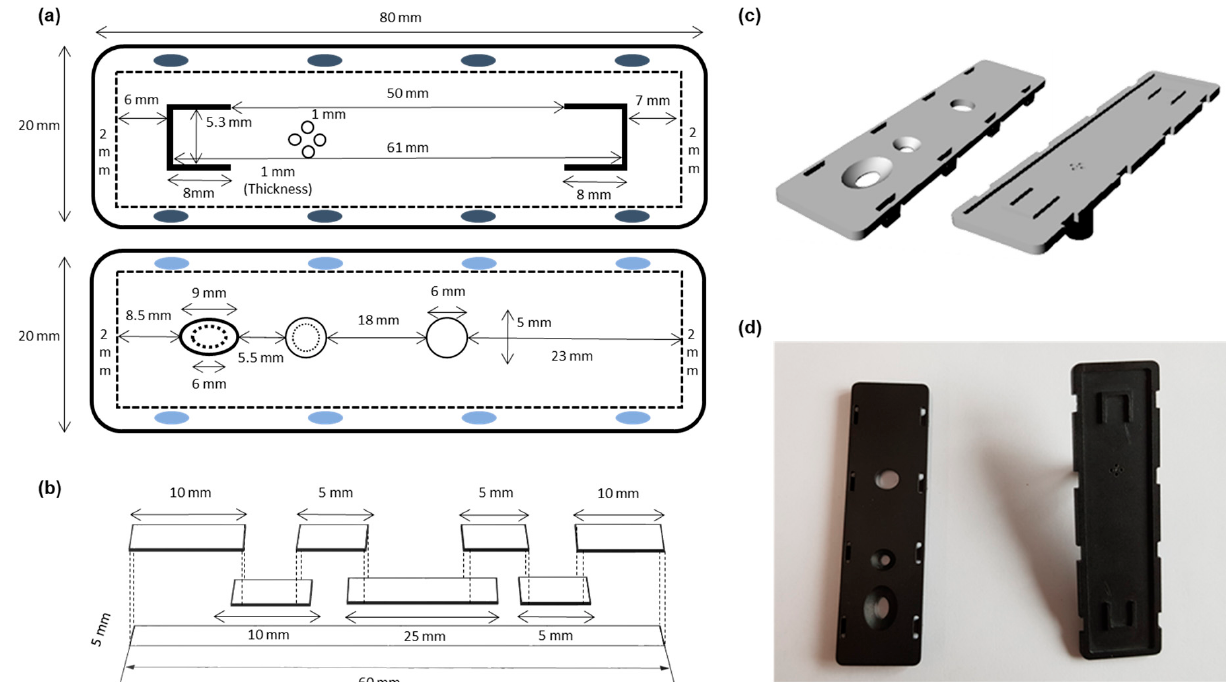
Figure 2. 3D printing of airborne bacteria collection kit. ( a ) Hand drawing of the 3D printing chip, ( b ) simple drawing of the paper strip with assembly line in the case, ( c ) CAD image, and ( d ) photograph of printed case.